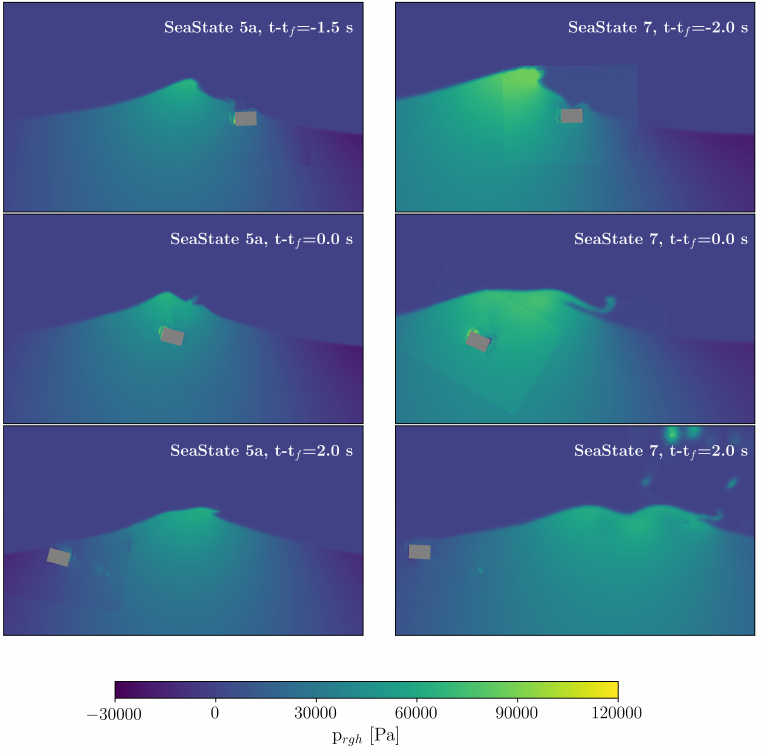
Figure 20. Wave–structure interaction at sea state 5a (left column) and sea state 7 (right column) as colored by the dynamic pressure, p _ rgh . The pictures on the top show the time instant in which the slamming occurs; the slamming happens 1.5 s and 2 s prior to the theoretical focus time for sea states 5a and 7, respectively. The pictures in the middle row depict the wave–structure interaction at the theoretical focused time, and the bottom pictures the wave–structure interaction as captured 2 s after the theoretical focus time. Both waves are breaking. At sea state 5a, the breaking phenomenon initiates just after the focused wave interacts with the buoy, whereas, at sea state 7, the wave starts to break in the frontal head of the